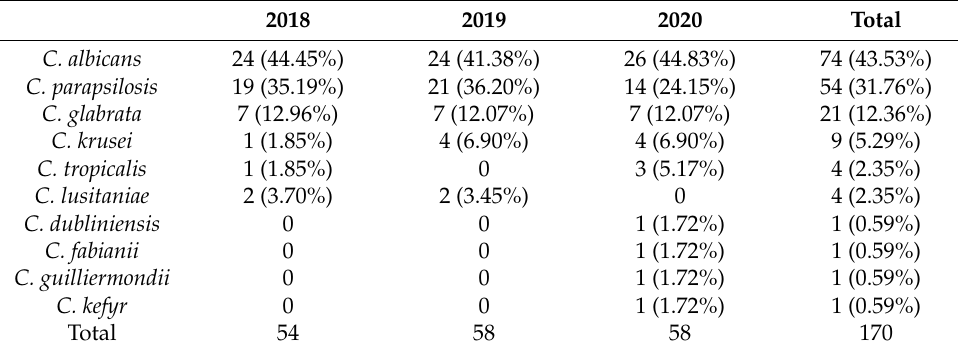
Table 3. Species distribution of Candida isolates in the three-year study period (2018–2020).